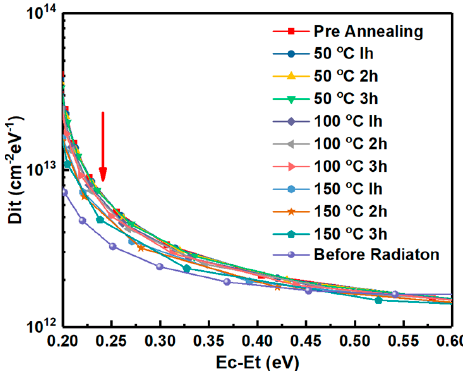
Figure 19. Energy distributions of interface states density in the sample at di ff erent stages of the isochronal annealing.